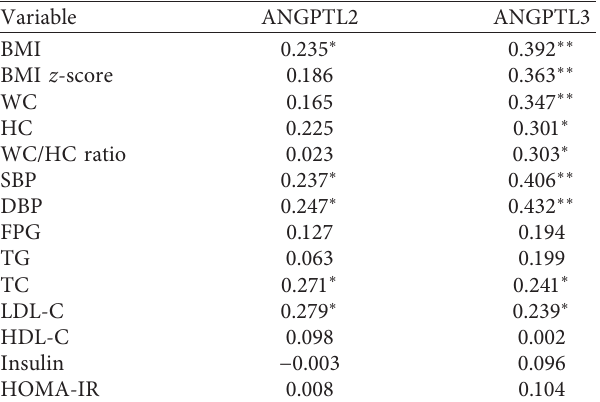
Table 2: Correlation coefficients of ANGPTL2 and ANGPTL3 plasma level with anthropometric and biochemical